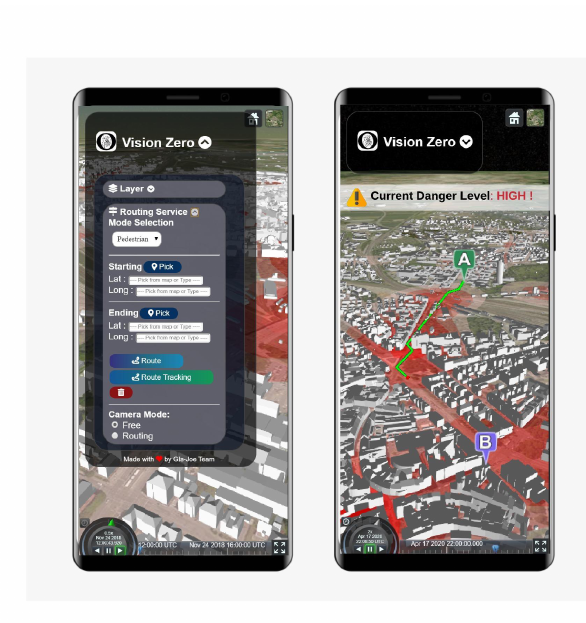
Figure 3. Application screenshots with screen sizes of 375x812, tested with Google-Chrome web